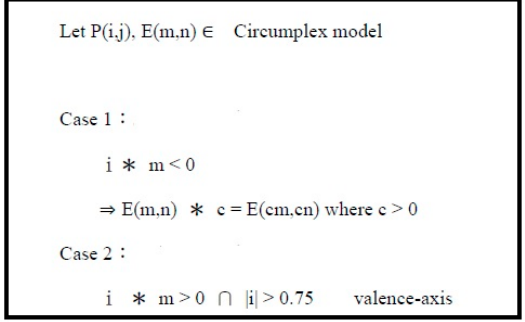
Figure 5. Principle of reason-generated operation.